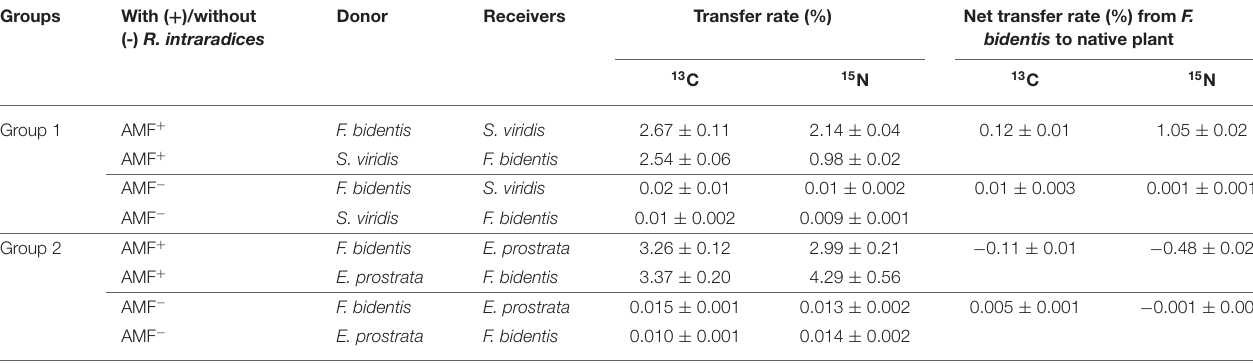
TABLE 1 | Carbon and nitrogen transfer between F. bidentis and two native plants ( S.viridis and E. prostrata ) mediated by R. intraradices . Groups With ( + )/without (-) R. intraradices